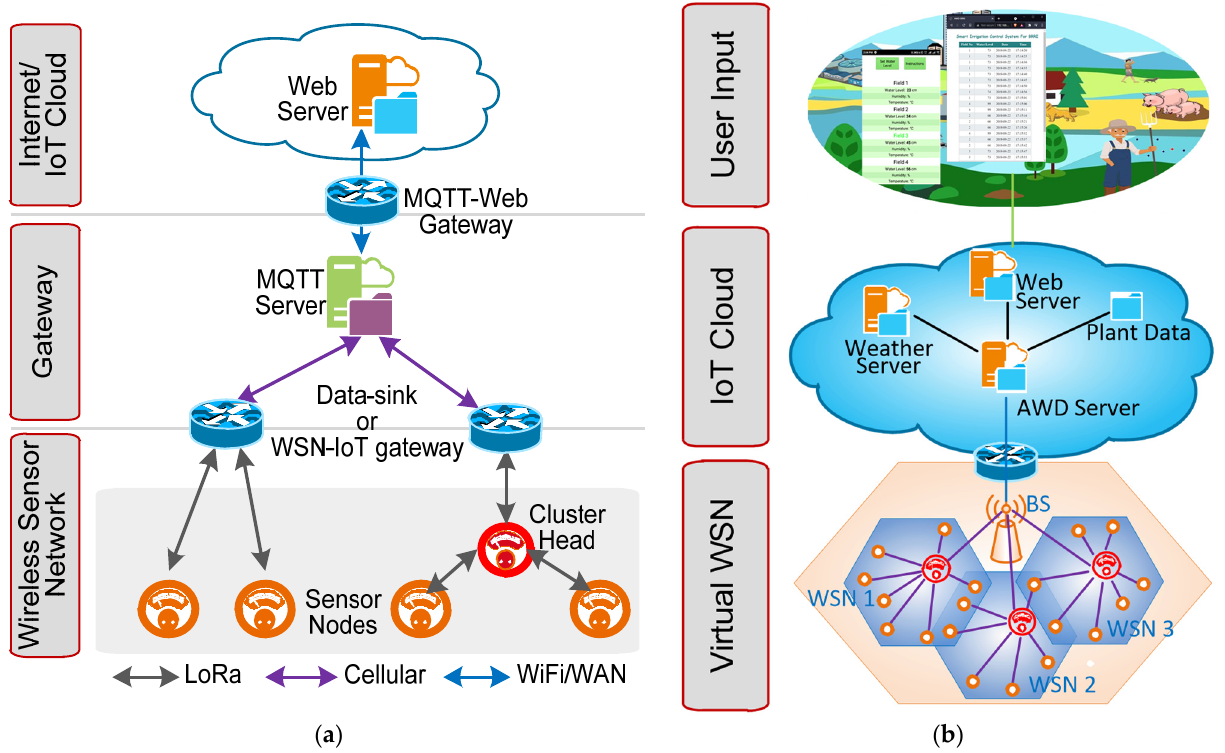
Figure 1. ( a ) Network elements and functional layers of the IoT-connected wireless sensor network (WSN), and ( b ) Automated AWD-specific WSN with IoT connectivity.